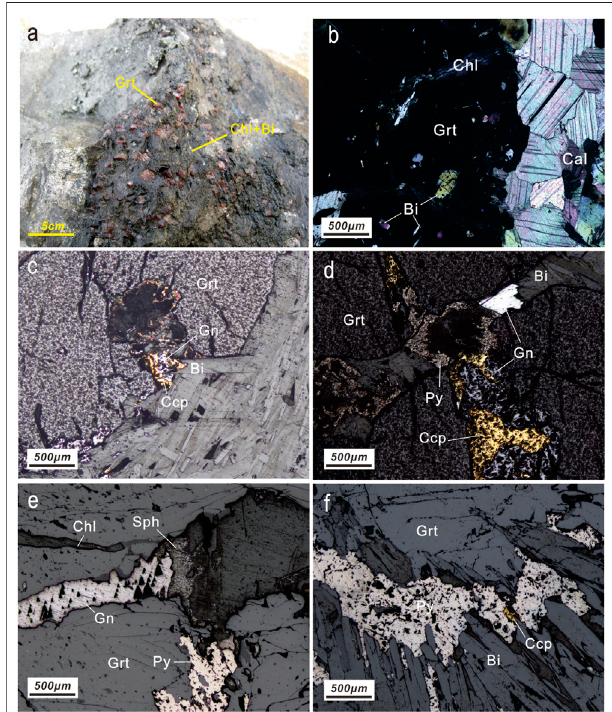
FIGURE 3 | (A) Reddish gem-garnet samples hosted in the greenschist from the Tiemurt deposit. (B) Biotite inclusion – rich Grt1 intergrown with chlorite and calcite. (C) and (D) Garnet1 coexists with chalcopyrite, chlorite, galena,andbiotite. (E) and (F) Chalcopyrite,sphalerite,pyriteintergrown with garnet2, biotite, and